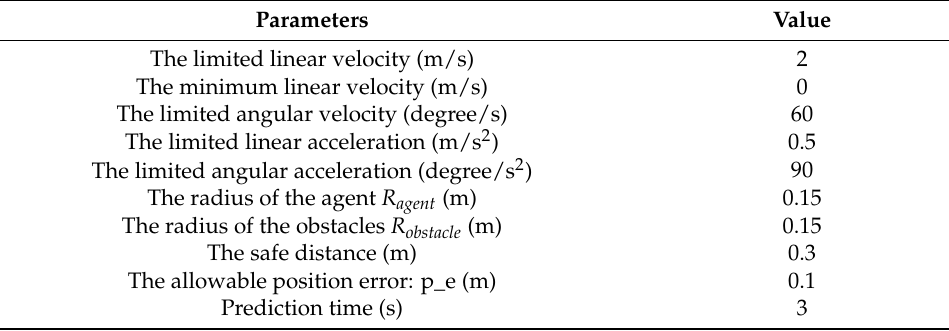
Table 6. Agent and obstacles parameters.